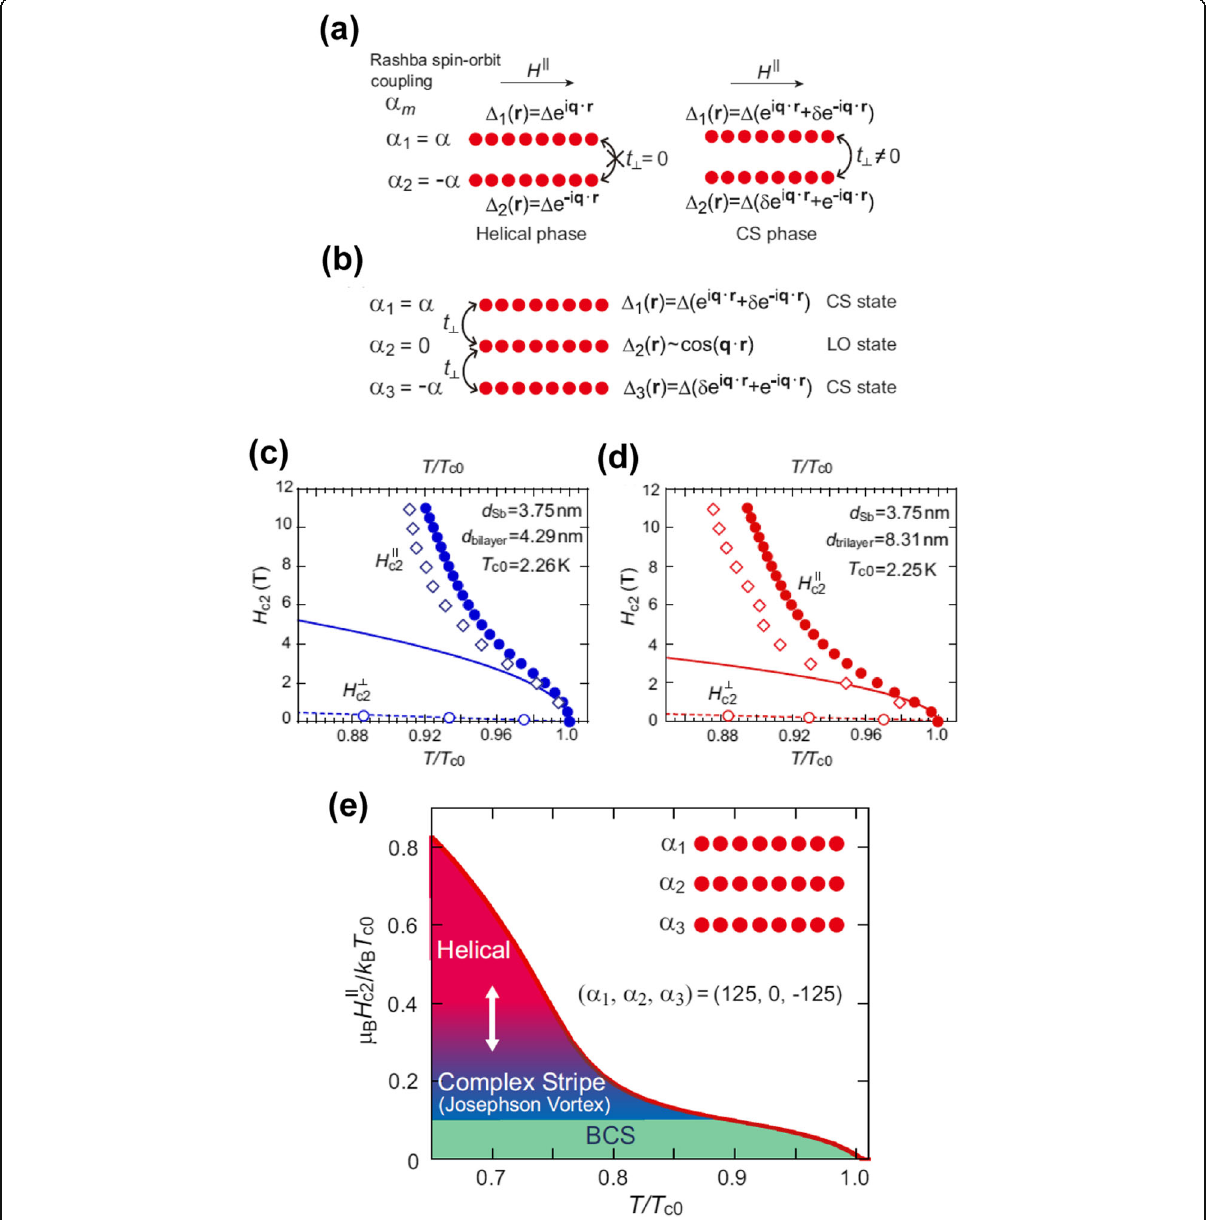
Fig. 11 In-plane critical magnetic field of quench-condensed Pb/Sb multiple layers on in situ cleaved GaAs(111). a , b Theoretical models for Pb bilayer ( a ) and Pb trilayer ( b ) systems in an in-plane magnetic field H ∥ . Each Pb layer is separated by a Sb layer. c , d Temperature dependences of the in-plane critical magnetic fields for Pb bilayer ( c ) and Pb trilayer ( d ) systems. e Theoretical prediction of the phase diagram for a Pb trilayer. Reprinted figure with permission from R. Masutomi et al. Phys. Rev. B 101, 184502 (2020) [98]. Copyright 2020 by the American Physical Society.